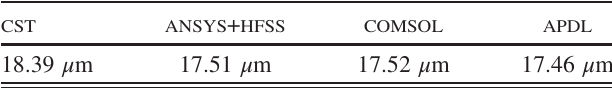
TABLE VIII. Maximum deformation for the set-up in Fig. 19.